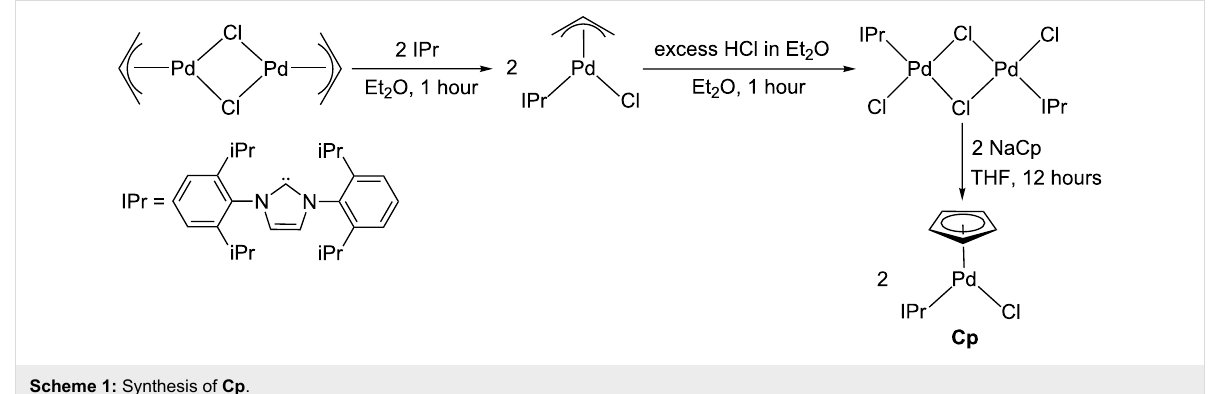
In organometallic chemistry, allyl and indenyl ligands are considered to be closely related to cyclopentadienyl (Cp) ligands [17]. Nevertheless, to the best of our knowledge there are only two reports describing the catalytic activity of complexes of the type ( η 5 -Cp)Pd(NHC)(Cl) for the Suzuki–Miyaura coupling, as well as related cross-coupling reactions [18,19]. These preliminary reports indicate that ( η 5 - Cp)Pd(NHC)(Cl) precatalysts are highly active. For example, full conversion at room temperature was achieved using simple aryl chlorides as the substrate in Suzuki–Miyaura couplings at relatively low catalyst loadings (1 mol %) [18]. However, despite this impressive activity, a direct comparison of the performance of ( η 5 -Cp)Pd(NHC)(Cl) type precatalysts with the related commercially available ( η 3 -allyl)Pd(NHC)(Cl) and ( η 3